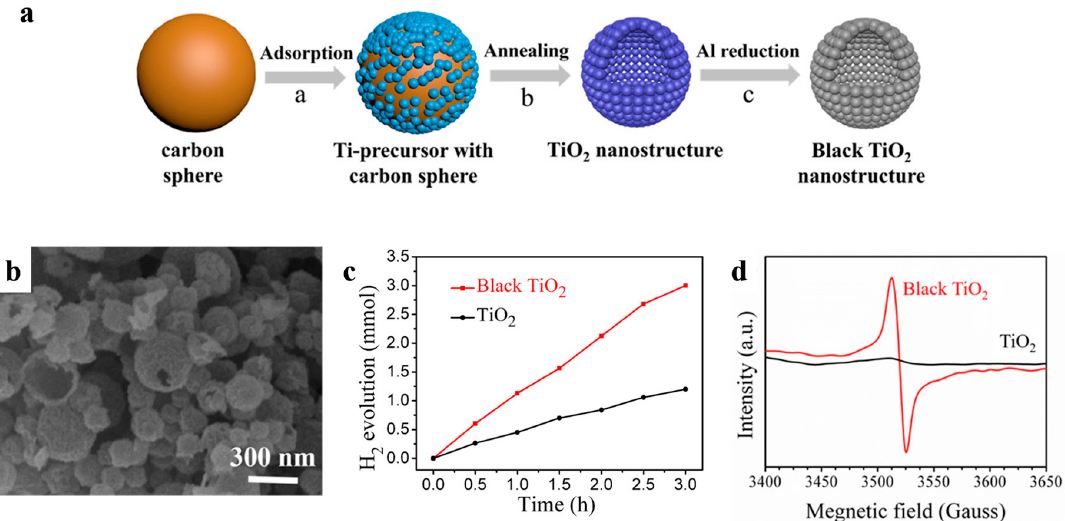
Figure 16. ( a ) The synthesis process of the as-prepared TiO 2 nanostructures and black ones. ( b ) SEM image of black TiO 2 . ( c ) Time course of photocatalytic H 2 evolution of TiO 2 nanostructures. Reaction conditions: 20 mg photocatalysts, 1 wt % Pt loaded, under 300W Xe lamp irradiation. ( d ) EPR spectra of the as-prepared TiO 2 hollow spheres and black ones. Reproduced with permission from [100]. Copyright American Chemical Society,